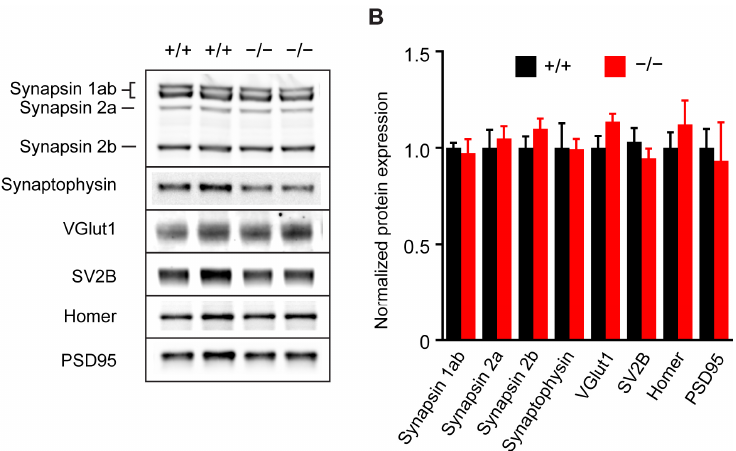
Figure 3. The expression of the key synaptic markers in the hippocampal synaptosomal fractions does not depend on astroglial Cx43 level. ( A ) Representative Western blots show a comparable protein expression of the synaptic markers in synaptosomal fractions, which were isolated from a wild-type (+/+) and a Cx43 − / − ( − / − ) hippocampus. ( B ) The quanti fi cation of protein expression normalized to +/+ level for each synaptic marker. Mean ± SEM; n = 5 (+/+) and 4 ( − / − ).